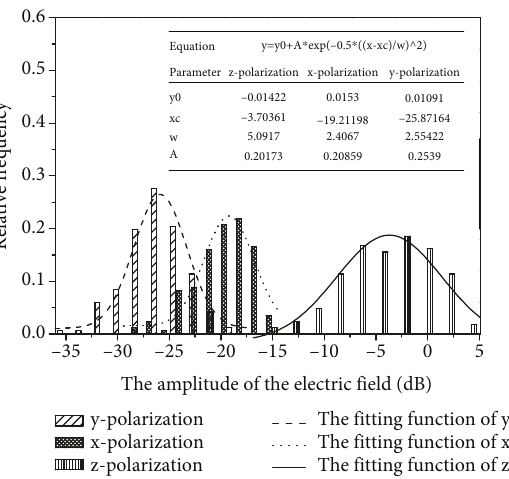
Figure 9: The probability density function (PDF) of the amplitude of the electric fi eld in the LOS corridor.